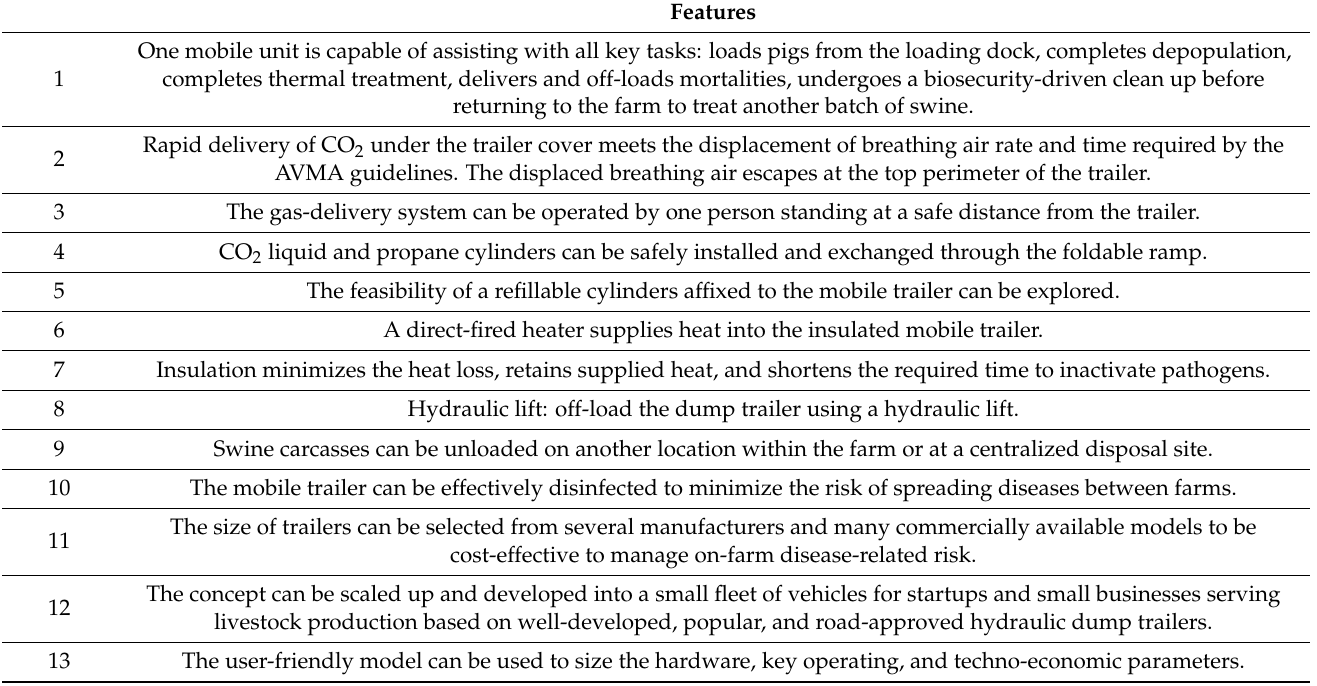
Table 2. Main features of the proposed all-in-one system. Features